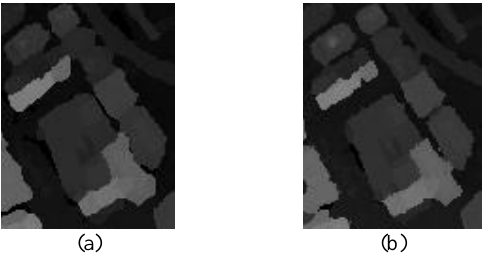
Figure 6. a) DSM generated from reliable points, b) the DSM after adding filtered non-reliable